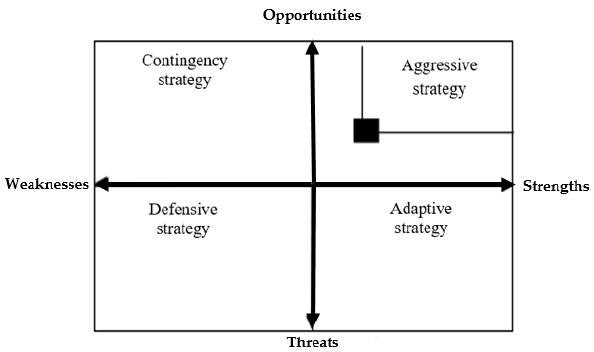
Figure 4 . Strategy planning in the SPACE matrix based on SWOT. Figure 4. Strategy planning in the SPACE matrix based on